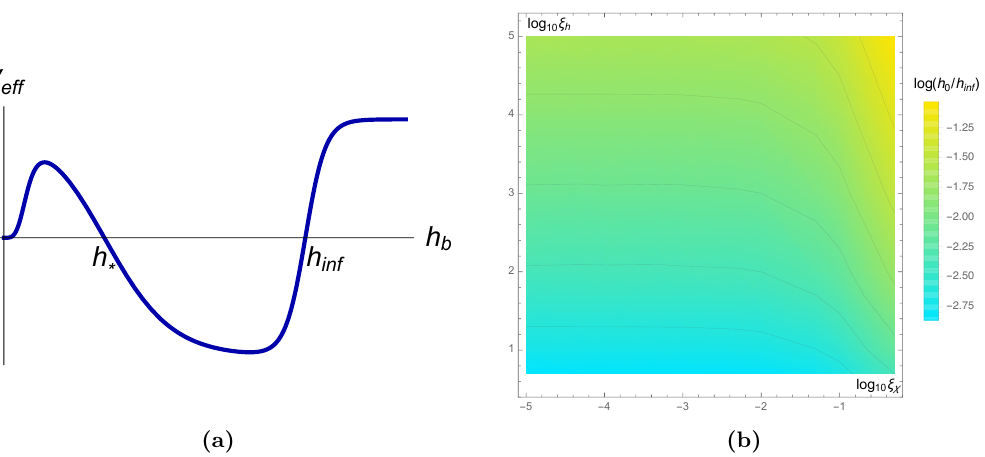
Figure 4. (a) Schematic form of the e(cid:11)ective potential in the Higgs-in(cid:13)ation scenario. (b) Mag- nitude of the bounce relative to the scale of the Higgs in(cid:13)ation. Here we take m t = 173 : 34 GeV and ^ (cid:22) = ^ (cid:22) I